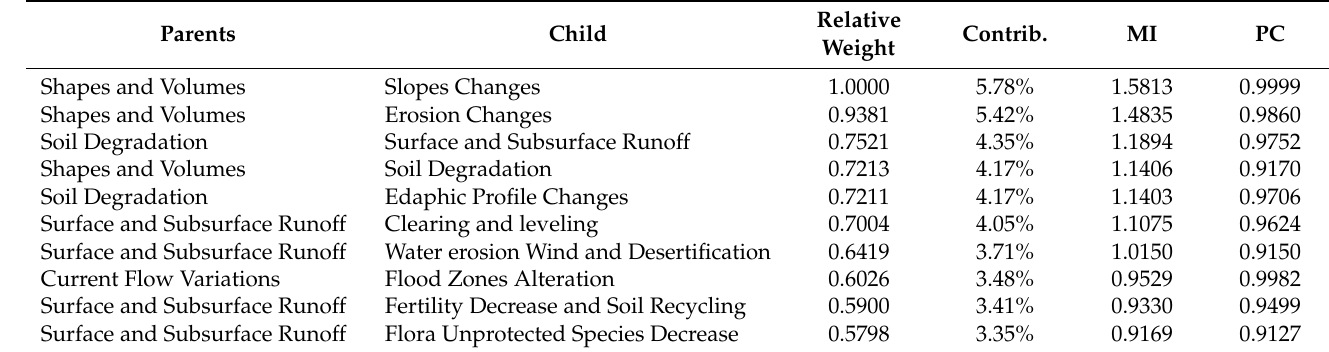
Table 2. Relationship analysis.